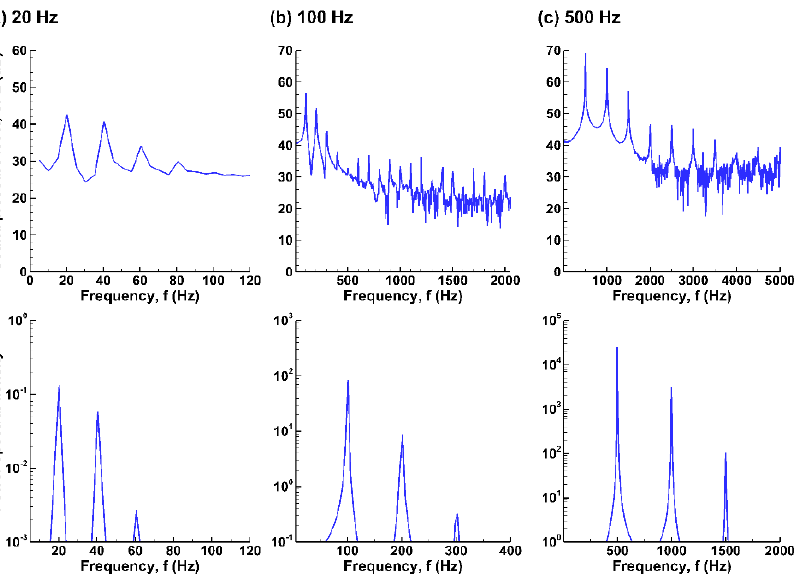
Figure 12. Sound pressure level ( upper panel ) and power spectral density ( lower panel ) in the low-frequency range at different glottal vibration frequencies: ( a ) 20 Hz, ( b ) 100 Hz, and ( c ) 500 Hz. Humans perceive sound differently, depending on the ear’s sensitivity to different acoustic frequencies. The A-weighted SPL (unit: dBA) was plotted in Figure 13 as a function of the octave band (Hz) for six glottal vibration frequencies. As human ears are more sensitive to sound frequencies between 500 and 6000 Hz, the peak loudness also occurred within this range (Figure 13b). A-weighted SPL generated at glottal vibration frequencies 10, 20, and 50 Hz are all below 40 dBA and, thus, should be inaudible to human ears. Increasing the glottal vibration frequency ( f 0 ) increased the perceived loudness both at individual acoustic frequencies ( f ) and total sound loudness (i.e., area under the curve between 20 and 20,000 Hz).